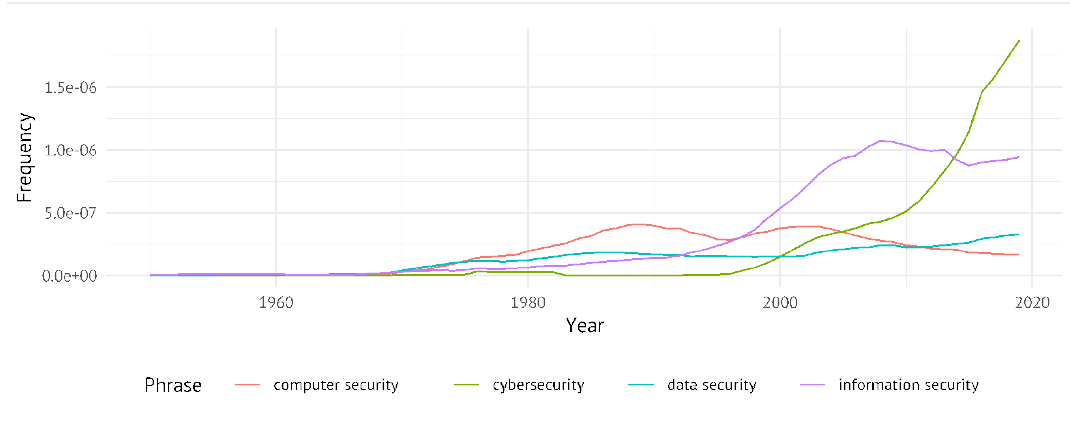
FIGURE 2: Google n-gram analysis (Lin et al., 2012) of the usage of variants of information security over time. Cybersecurity encompasses cybersecurity , cyber security and cyber-security . Retrieved using ngramr (Carmody,